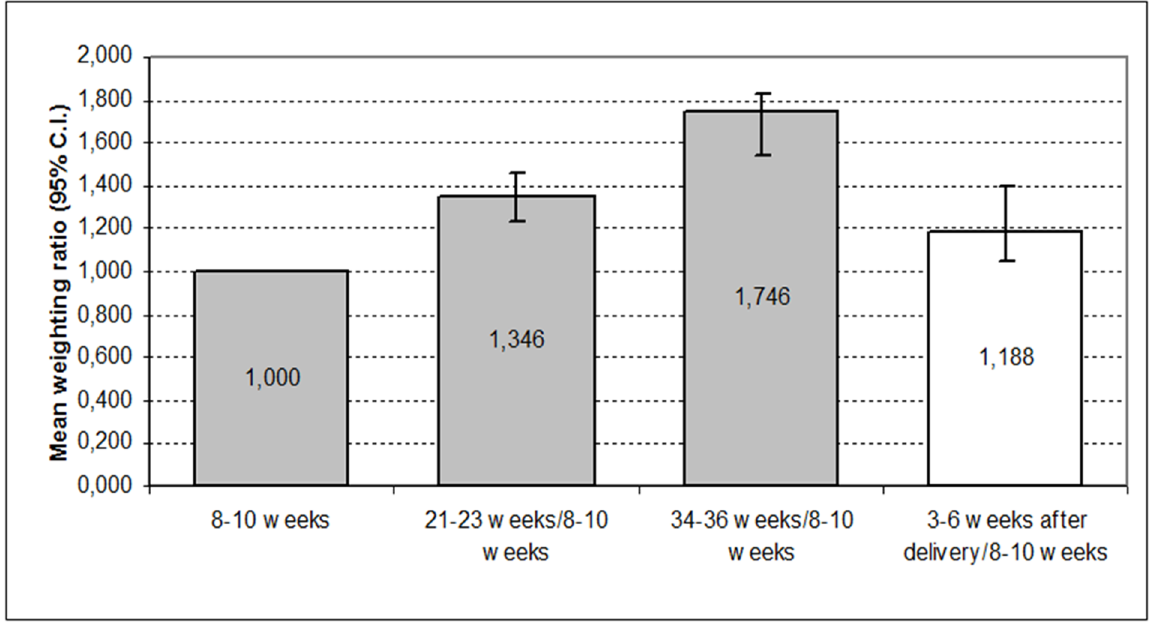
Fig 2. Comparisons of proportion of sites with probing depth > 3mm during pregnancy and